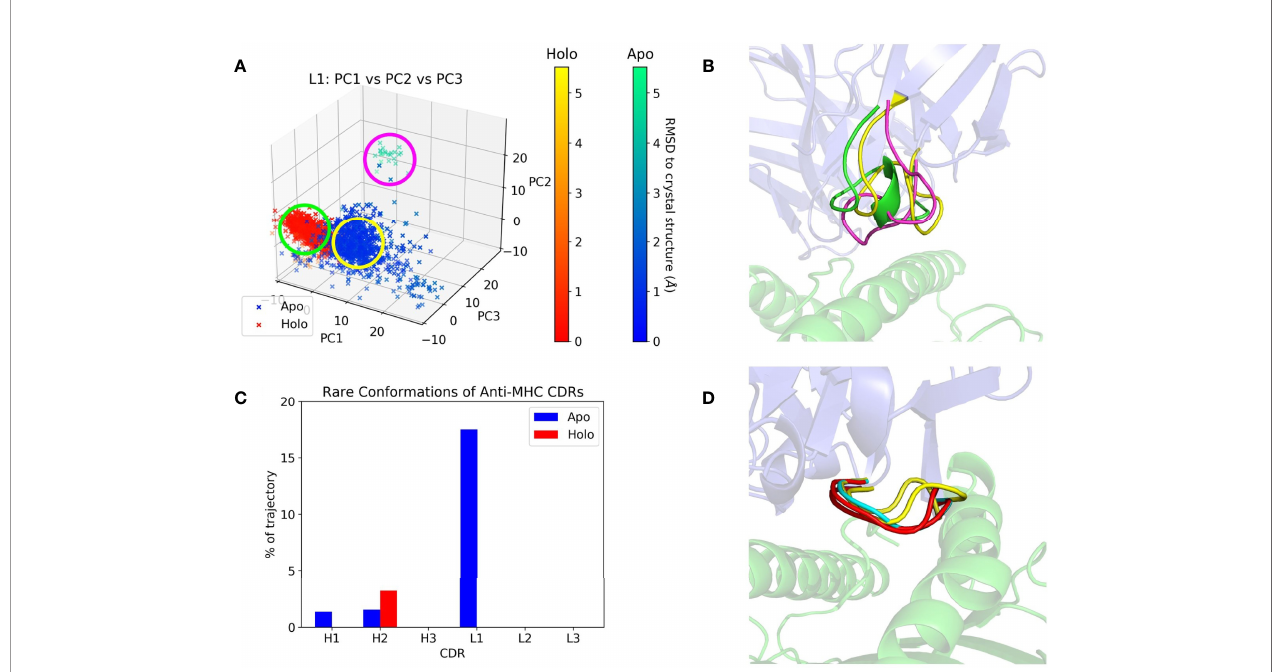
FIGURE 3 | Anti-MHC PCA and DASH examples. The Fv is in blue and the antigen in green on the right sub fi gures. (A) Apo and holo anti-MHC frames projected along the fi rst three PCs of L1, with frames colored by RMSD with respect to their crystal structure conformation. (B) Representative structures of L1 conformations, with colors corresponding to the circles in (A) . (C) Percentage of each CDR ’ s trajectory classi fi ed as rare in DASH, showing H2 with more rare conformations in its holo state. (D) Representative structures for H2 ’ s apo-unique (cyan), holo-unique (red), and matched conformations present in both trajectories (yellow).